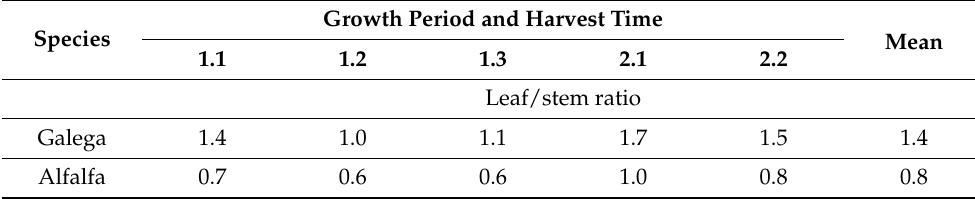
Table 6. Leaf/stem ratio of galega and alfalfa in two growth periods and different harvest times.